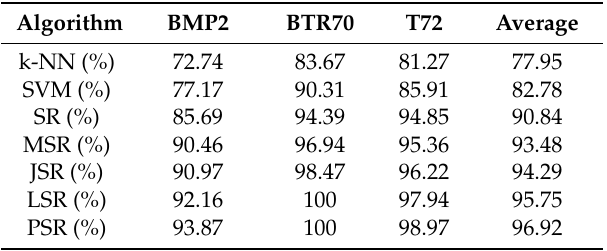
Table 2. The recognition results for the 3-type